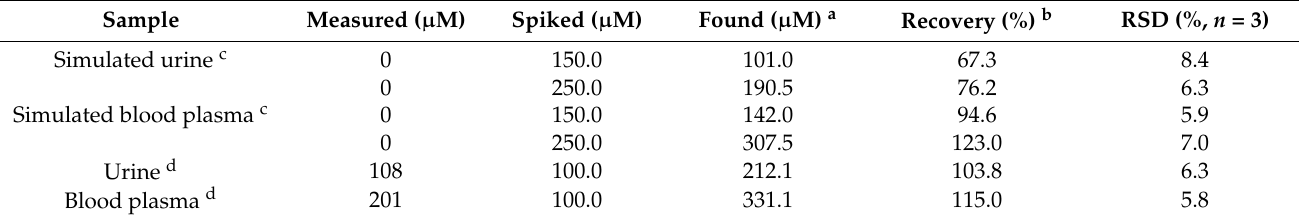
Table 3. Application of the method to the analysis of real